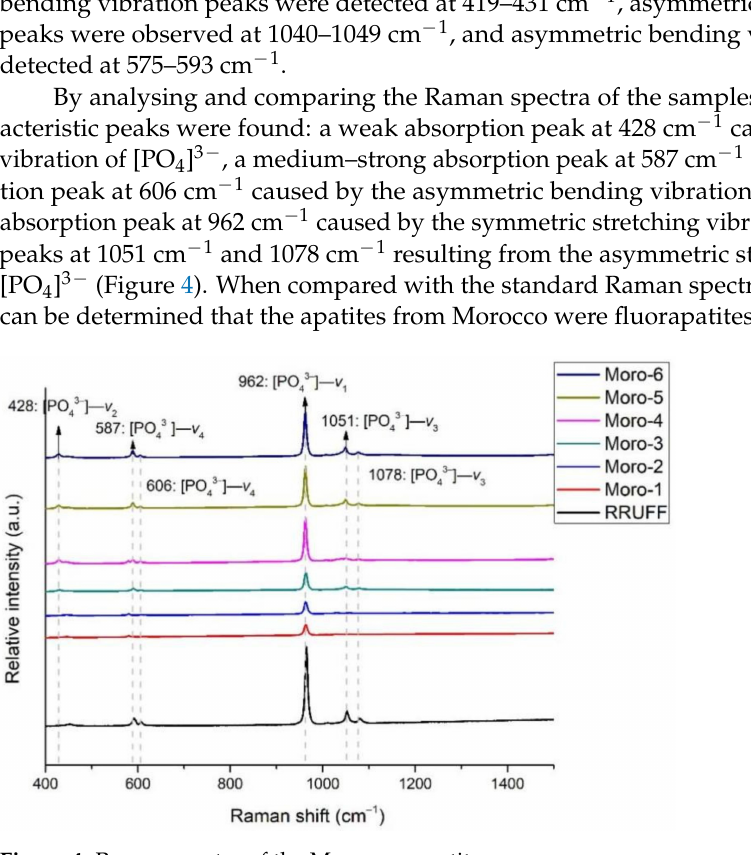
Figure 4. Raman spectra of the Moroccan